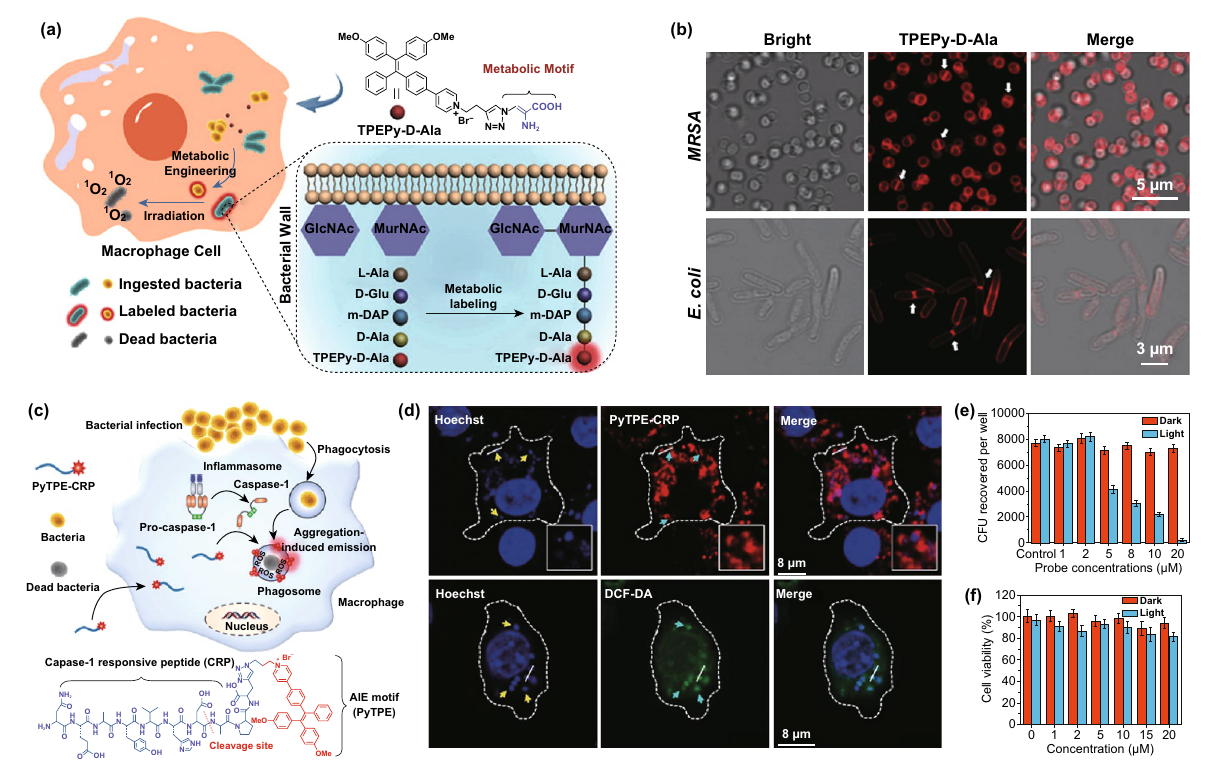
Fig. 7 a Schematic illustration of TPEPy-D-Ala probe against intracellular bacterial. Involved in the metabolism of peptidoglycan, d -alanine allows the metabolic labeling of bacterial peptidoglycan by probe. b CLSM, bright field and merged images of TPEPy-D-Ala probe-treated MRSA and E. coli [84]. Copyright 2019 Wiley-VCH. c Schematic of PyTPE-CRP photosensitizer for intracellular bacterial diagnosis and elimi- nation. d CLSM images of the PyTPE-CRP localization o in S. aureus -infected Raw 264.7 macrophages. White dashed lines indicate cellular outline. The S. aureus are shown with yellow arrows. Cyan arrows represent S. aureus -contained phagosomes. The DNA of bacterial cells and Raw 264.7 macrophages are labeled with blue Hoechst dye. e Intracellular survival of S. aureus in Raw 264.7 macrophages treated with PyTPE- CRP. f Viability of Raw 264.7 macrophages in the presence of PyTPE-CRP photosensitizer [85]. Copyright 2019